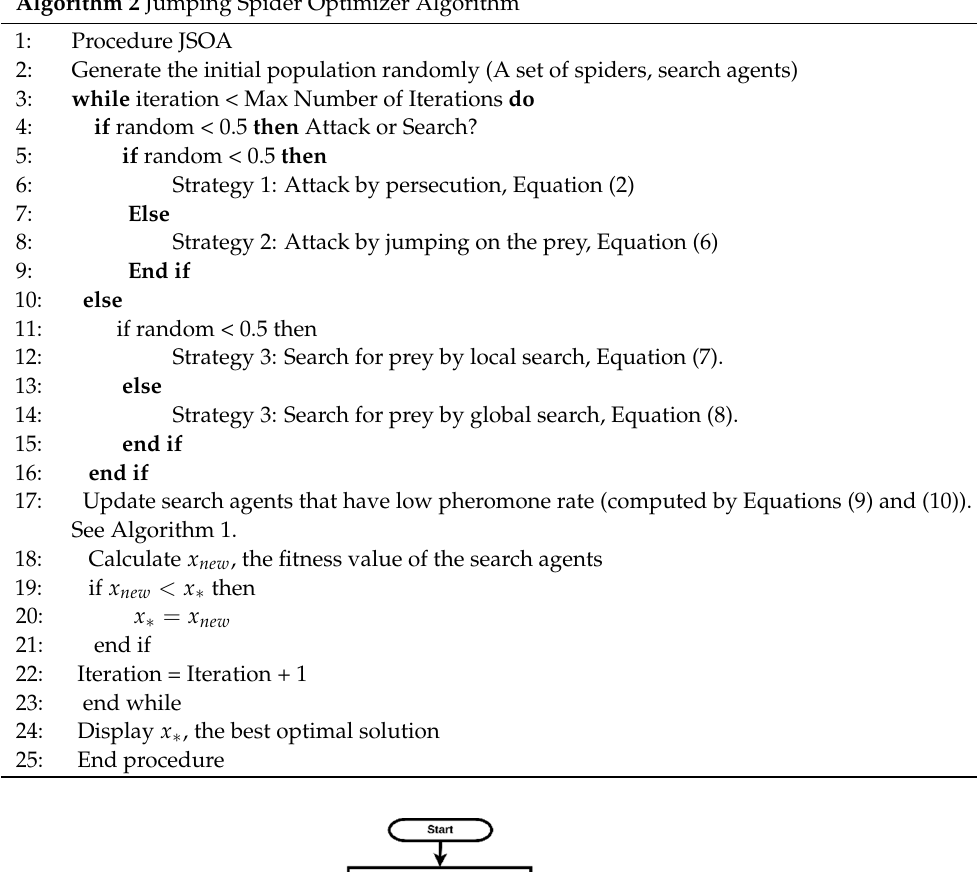
Algorithm 2 Jumping Spider Optimizer Algorithm